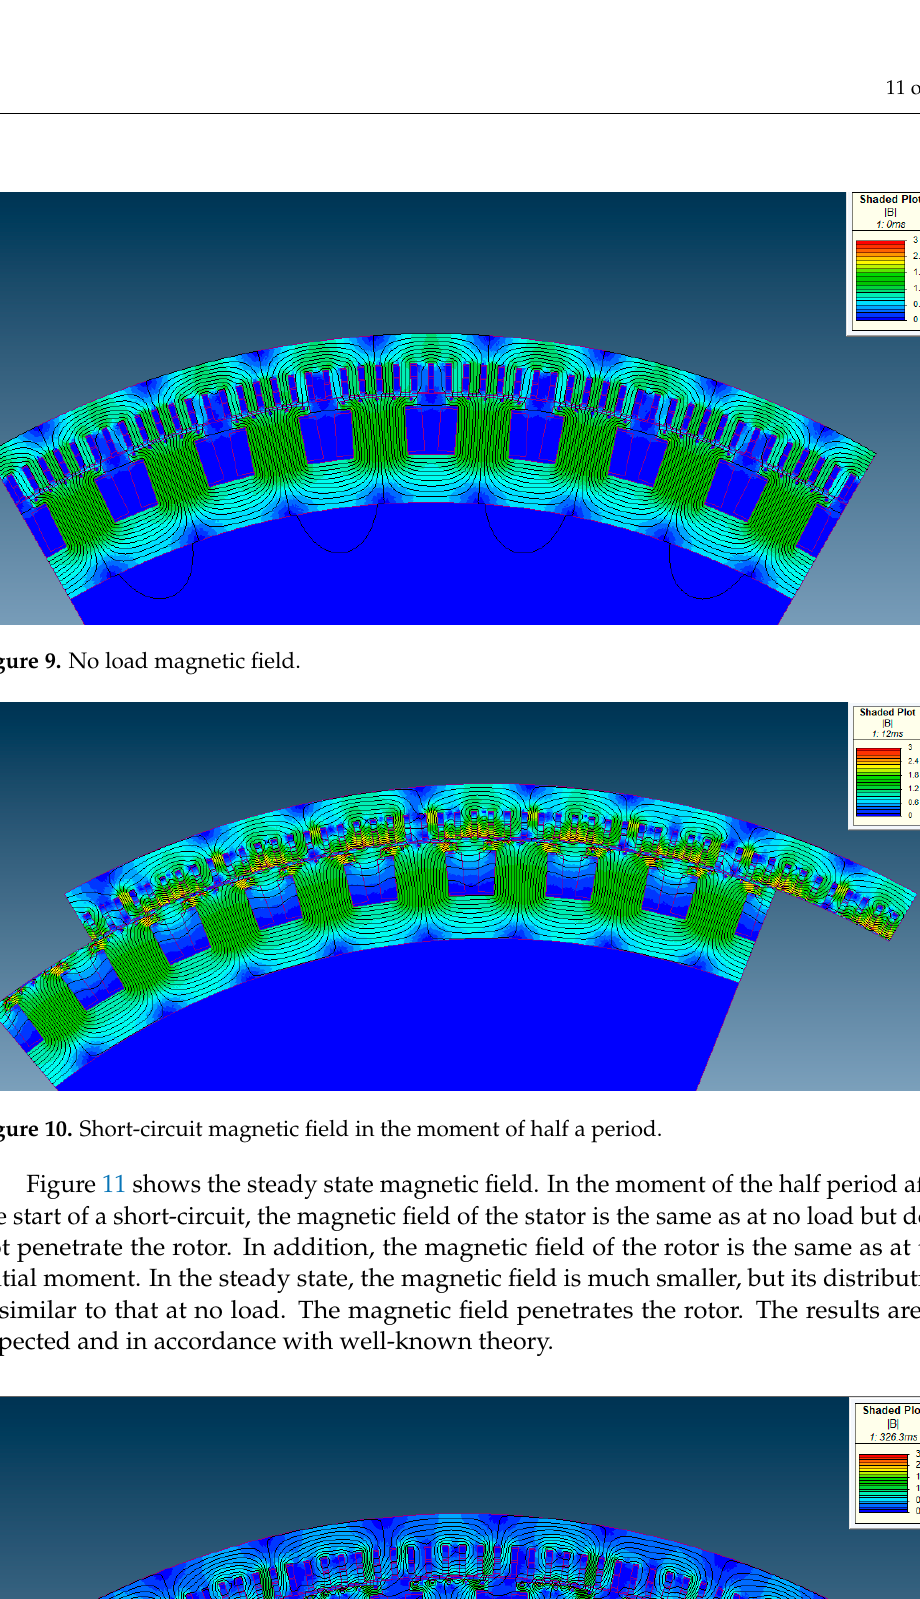
Figure 11. Steady state magnetic field.